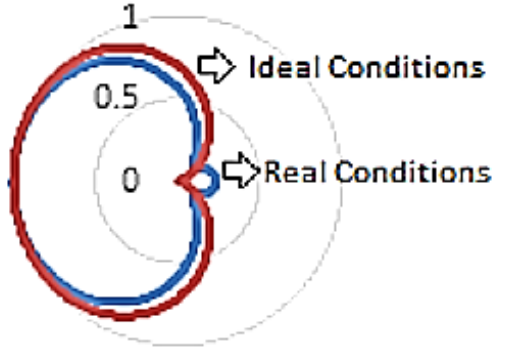
Figure 6. The effect of mutual coupling on the 0.25 λ array radiation pattern under ideal and real conditions.